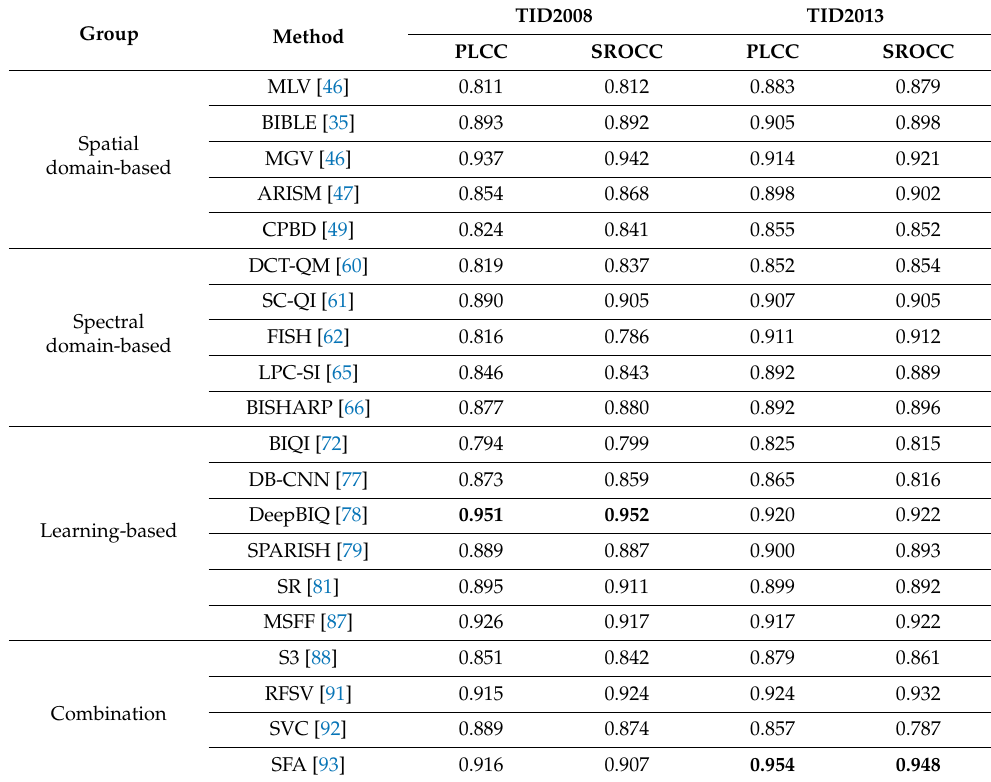
Table 6. Comparison of different evaluation methods on TID2008 dataset and TID2013